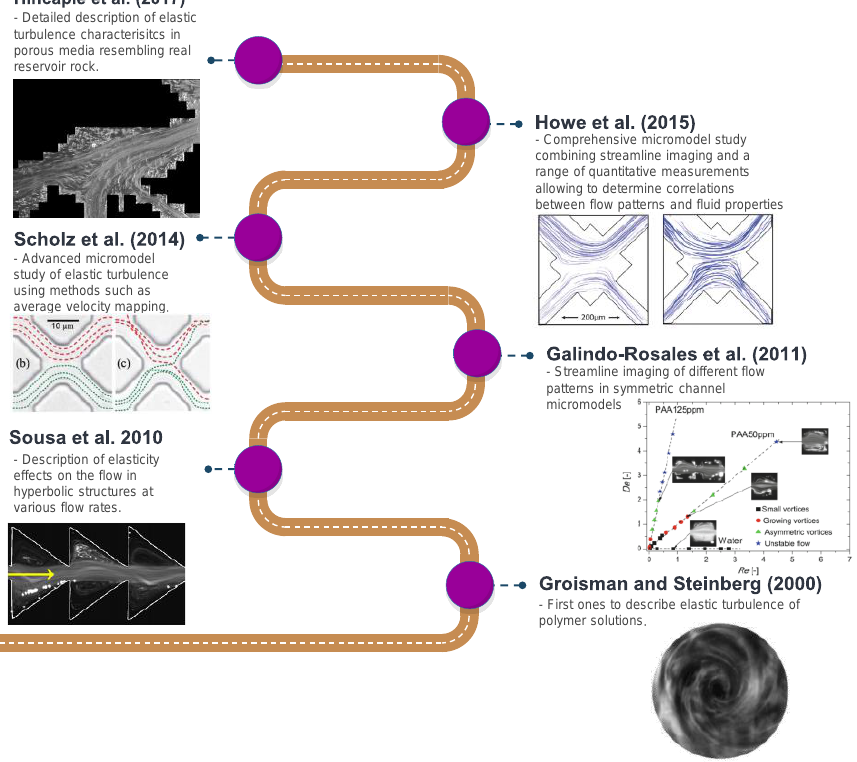
Figure 6. Recent evolution of elastic turbulence visualization (based on Groisman and Steinberg [31], Sousa et al. [73], Galindo-Rosales et al. [61], Scholz et al. [59], Howe et al. [25], Hincapie et al. [29]).